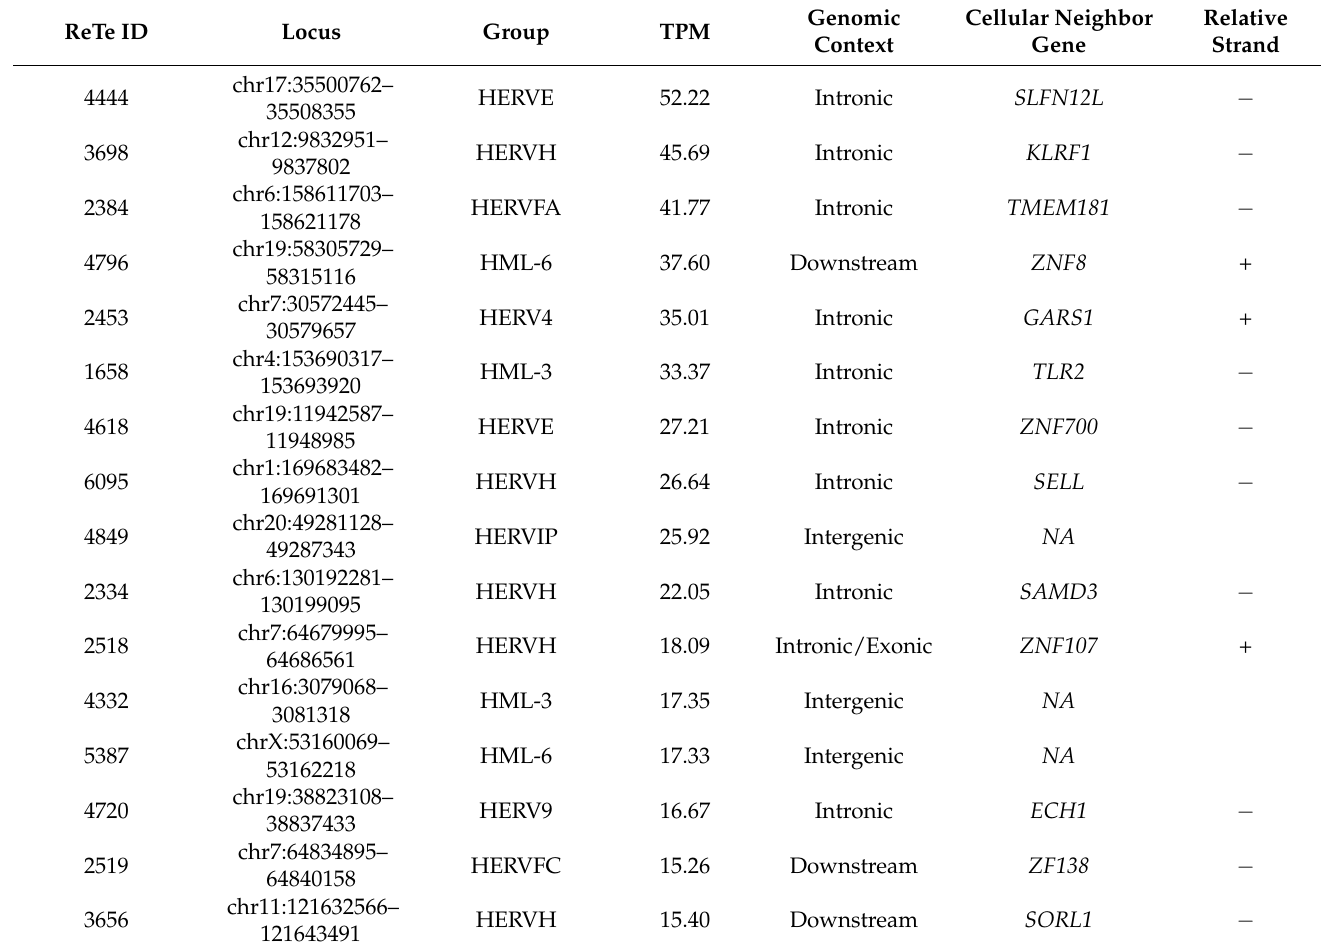
Table 1. 16 highly expressed HERV proviruses in PBMCs and their context of insertion. Genomic Cellular ReTe ID Locus Group TPM